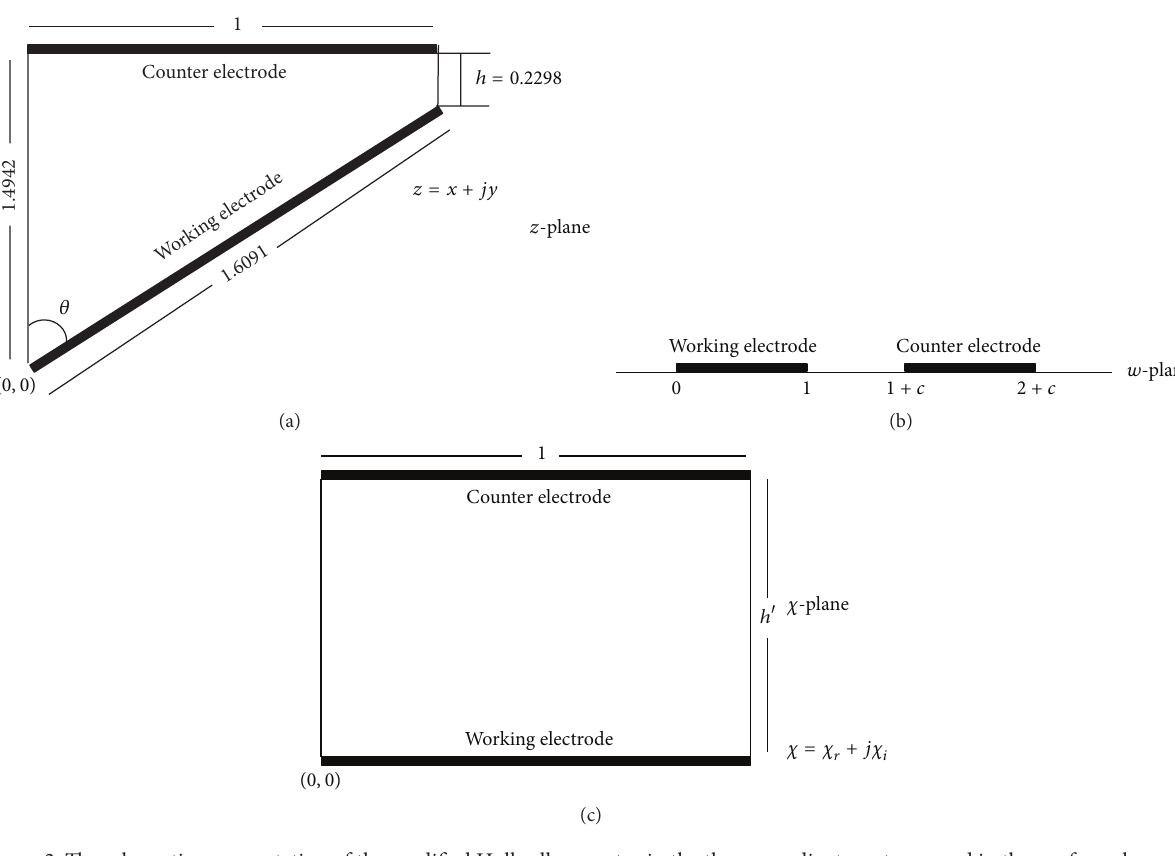
Figure 2: The schematic representation of the modified Hull cell geometry in the three coordinate systems used in the conformal mapping: (a) 𝑧 -plane; (b) 𝑤 -plane; (c) 𝜒 -plane